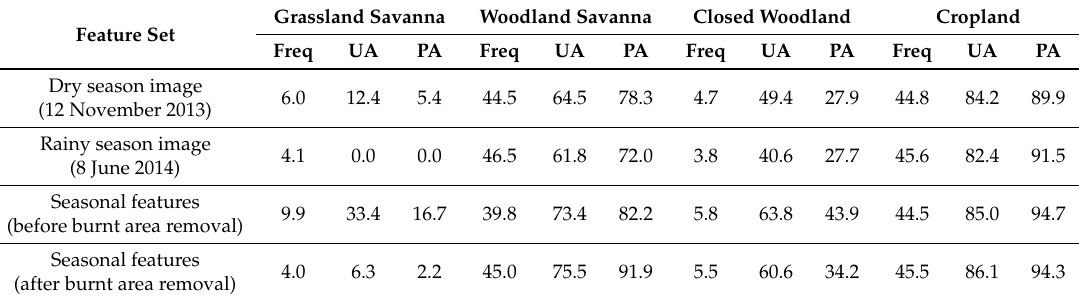
Table 3. User’s accuracy (UA, %) , producer’s accuracy (PA, %), and percentage of different land cover types (Freq, %) for classifications in Table 2 (selected